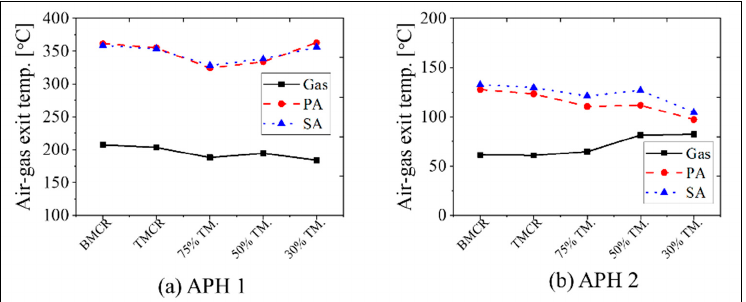
Figure 9. Simulation results for the flue gas and air temperature at the exit of the APH 1 and APH 2 based on the five load conditions: ( a ) APH 1 and ( b ) APH 2.